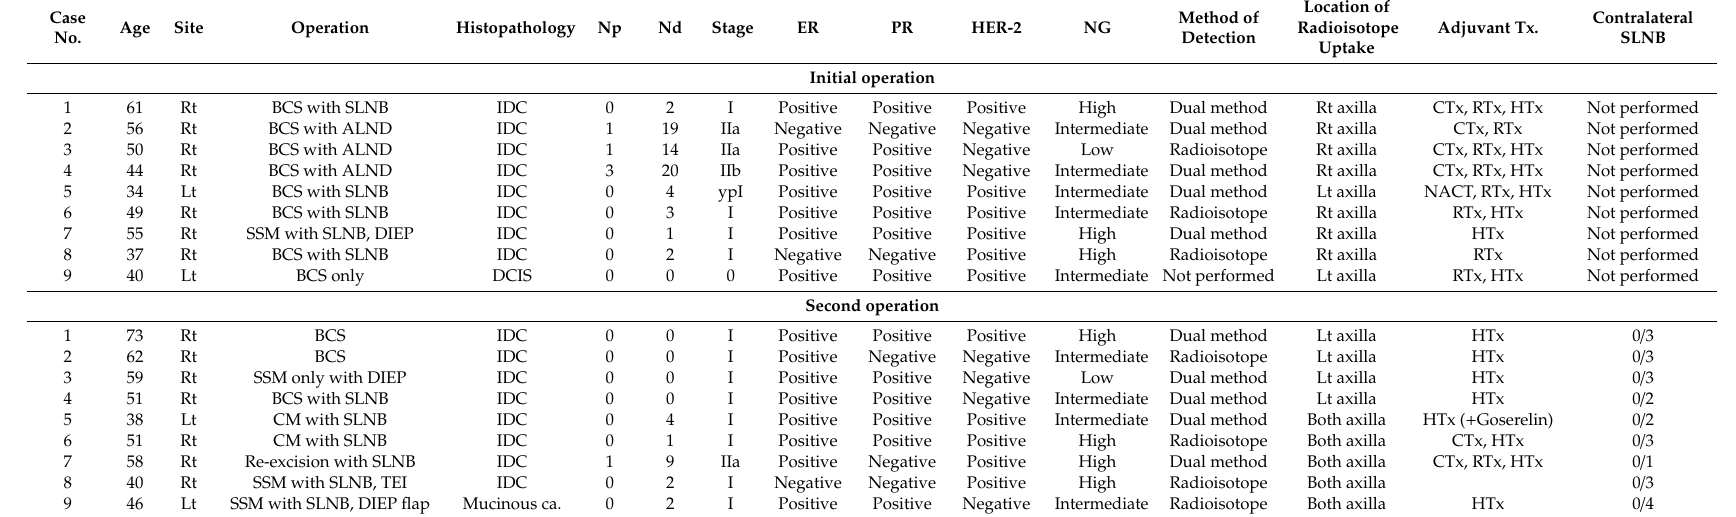
Table 2. Characteristics of patients who had isolated ipsilateral breast tumor recurrence (IBTR) and underwent contralateral sentinel lymph node biopsy. Case No.